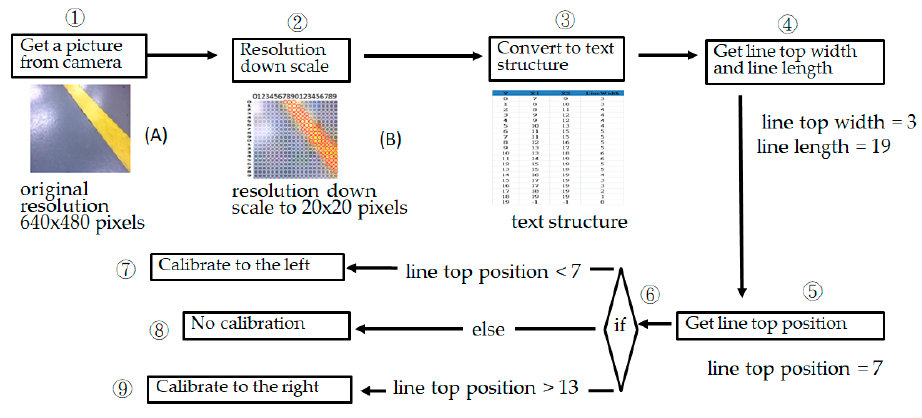
Figure 6. Image recognition process block diagram.